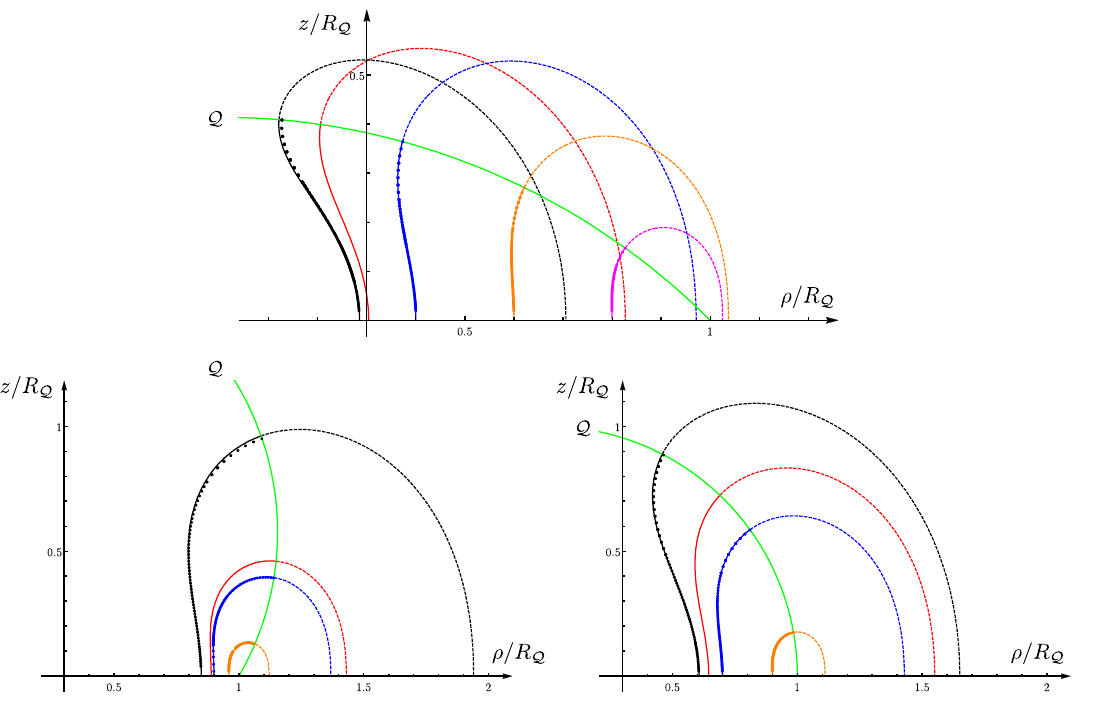
Figure 6 . Radial pro(cid:12)les of extremal surfaces ^ (cid:13) con